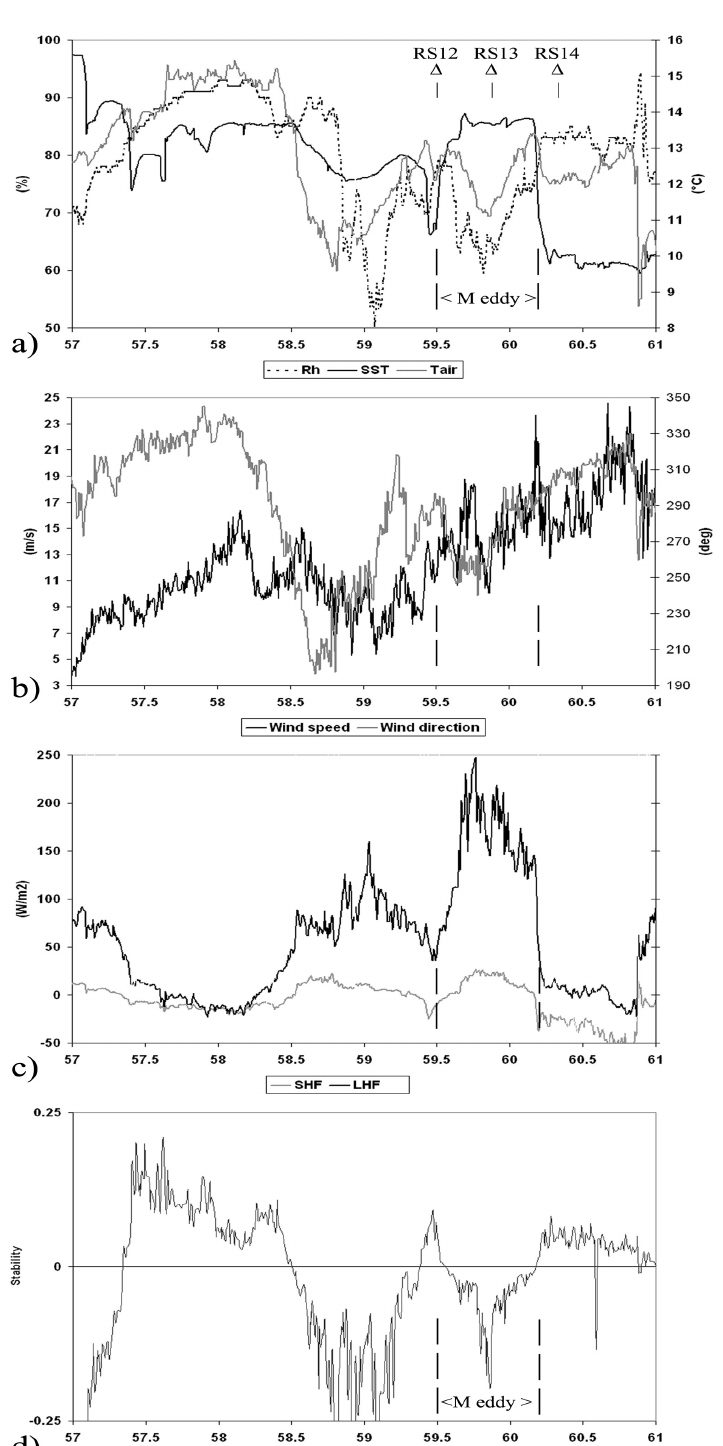
Fig. 6. Time series for (a) relative humidity (dashed black curve; left vertical axis), SST and air temperature (black and grey curves re- spectively; right vertical axis); (b) wind speed and direction (black and grey lines respectively), left vertical axis is wind speed and right vertical axe is direction; (c) sensible and latent heat fluxes (grey and black curves respectively); (d) stability parameter at ten meters height, ζ 10 = 10 /L , L is the Obukhov length; ζ positive for stable conditions, ζ negative for unstable conditions. For all the frames, the horizontal axis is the day number after the 1 January 2008. The vertical dashed black lines are the location of the oceanic fronts. The location of the RS12, RS13, RS14 releases is